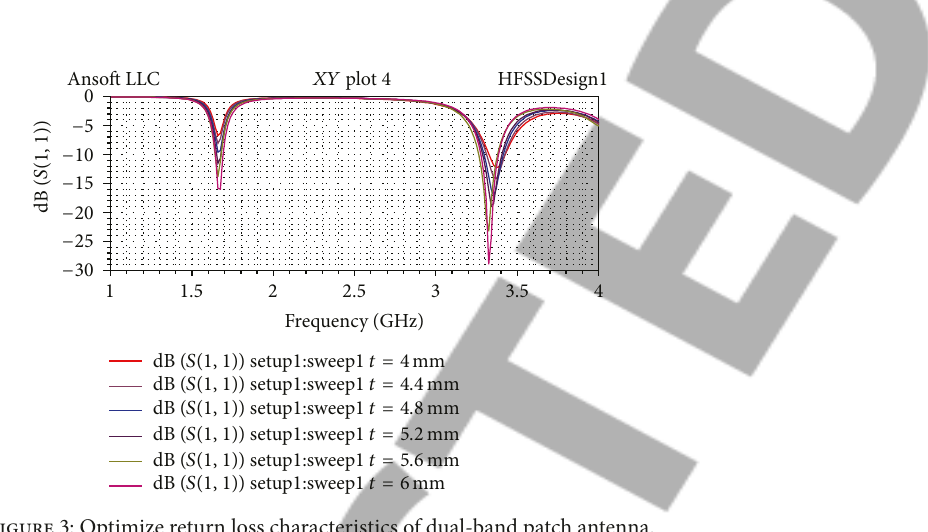
Figure 3: Optimize return loss characteristics of dual-band patch antenna.